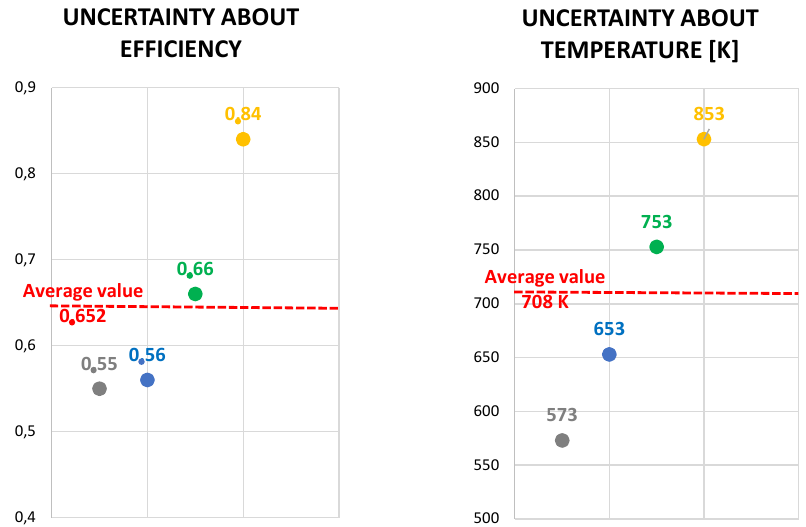
Figure 9. Dispersion of efficiency and temperature values of the four identified solutions. Starting from the calibration parameters of the model that characterize solution CR.4, the interaction between the exhaust gas from the methane combustor and the pulper at ambient temperature (293 K) within the mixing region of the rotary drum has been ana- lyzed (Figure 10).